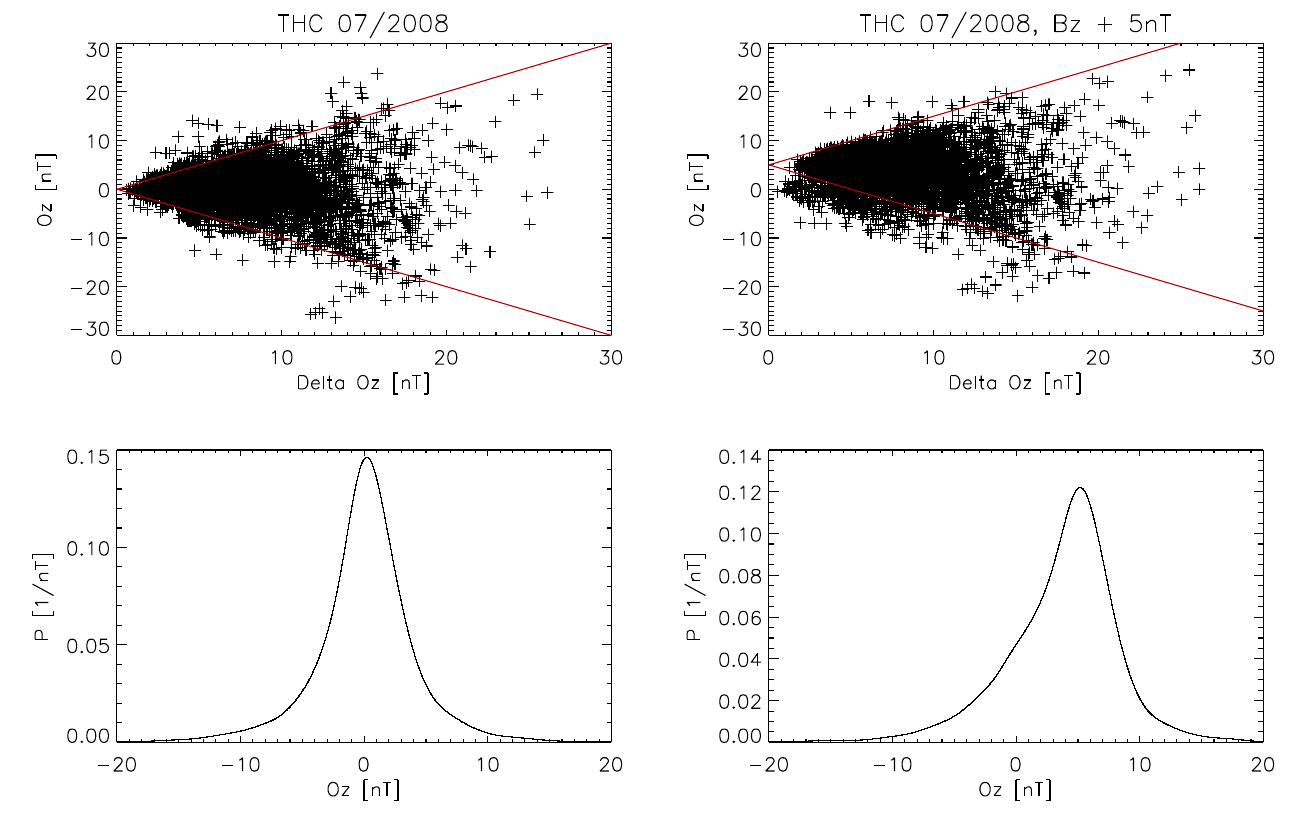
Figure 3. Top panel: O z over (cid:49)O z estimates obtained from mag- netosheath magnetic field observations by THC in July 2008. The red lines depict O z = ± (cid:49)O z . Bottom panel: corresponding proba- bility density distribution P determined by the KDE method using a Gaussian kernel and a bandwidth of h = 1nT.